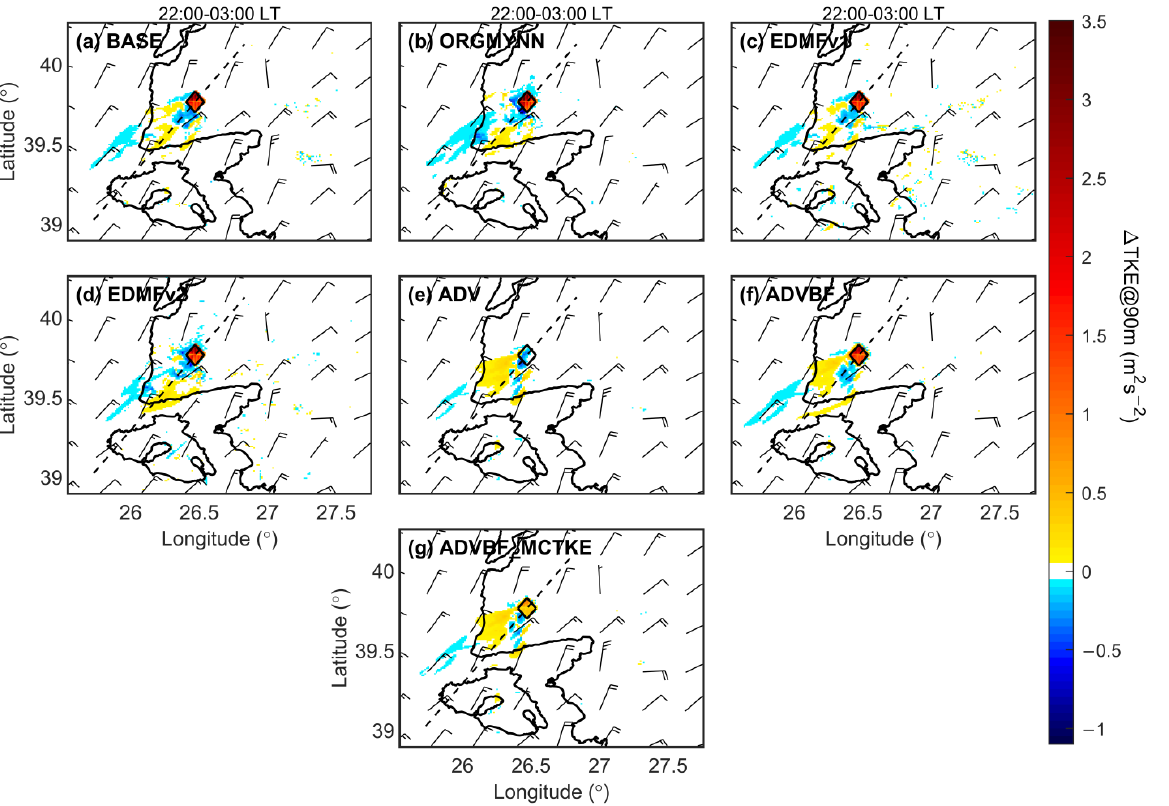
Figure 6. The wind farm wake impact on hub-height TKE for the simulations of ( a – g ) BASE, ORGMYNN, EDMFv1, EDMFv2, ADV, ADVBF and ADVBF_MCTKE. Wind barbs from the WRF- WFP simulation are plotted in knots for every 27 km. The thick black line represents coastlines. A thin dashed black line crossing the wind farm represents a vertical cross-section line. The square box represents the wind farm area.